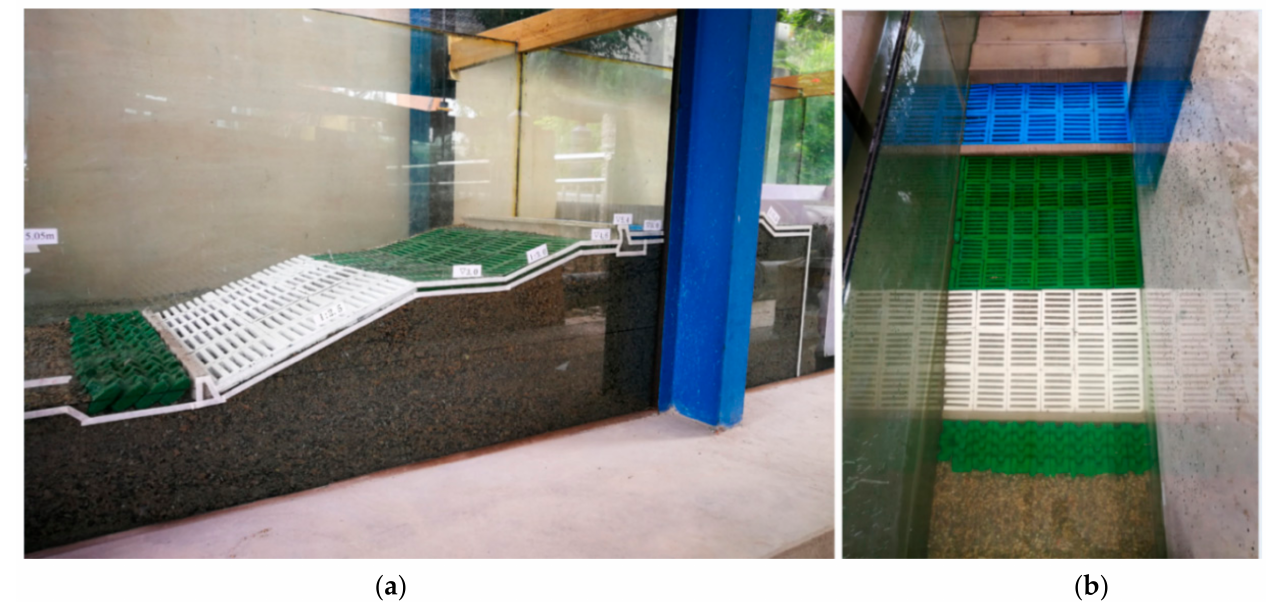
Figure 3. Physical experimental layout; ( a ) side view; ( b ) top